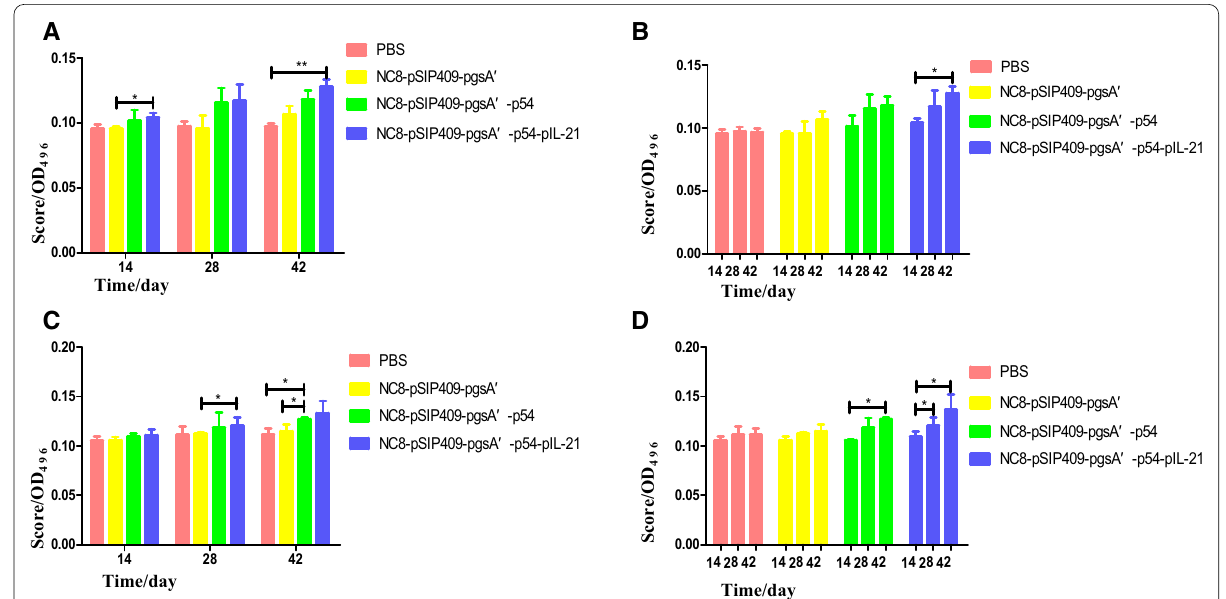
Fig. 3 A Comparison of the increase in fecal IgA content in the four groups of mice after three immunizations. B Comparison of the increase in the fecal IgA content of the four groups of mice after each immunization. C Comparison of the increase in the fecal IgG content of the four groups of mice after three immunizations. D The increase in the fecal IgG content of the four groups of mice after each